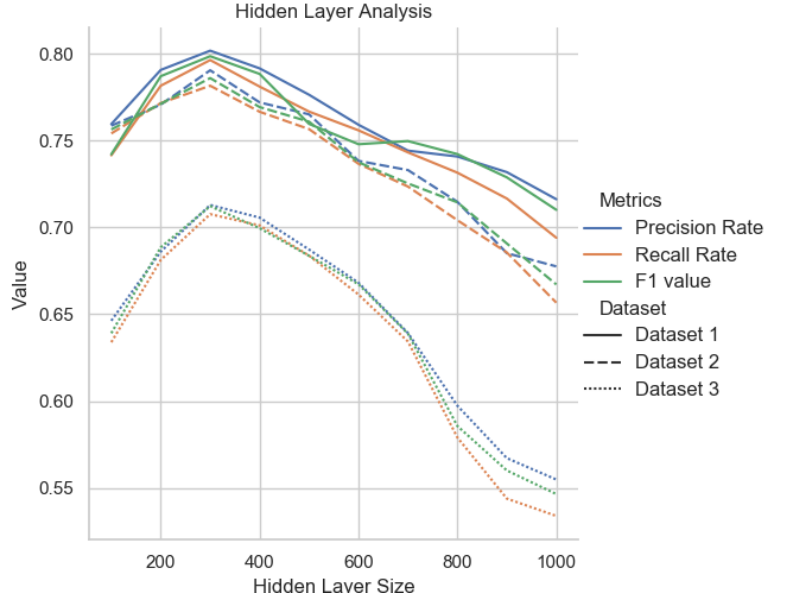
Figure 8. Hi-STEM results with different hidden layer length. Different colors represent different indicators, and different lines represent different data sets. It can be seen from the figure that under different data sets, the effect of the model is the best when the hidden layer size is